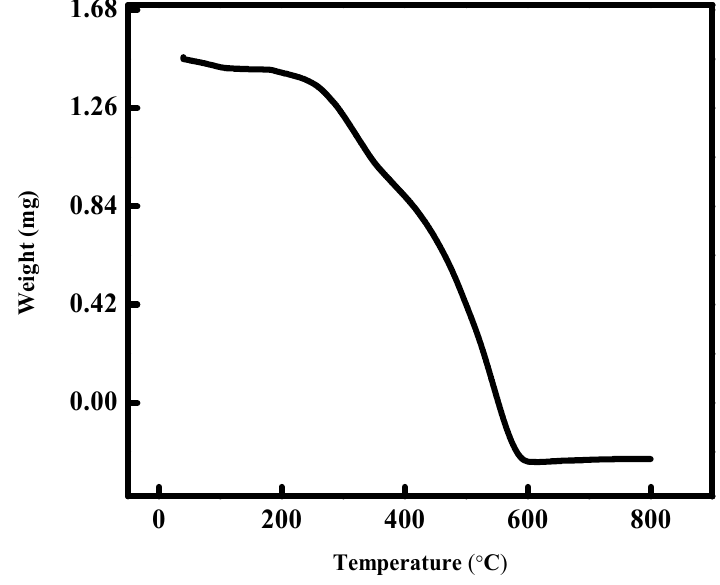
Figure 4. Thermogravimetric analysis (TGA) plot of the synthesized PANI.